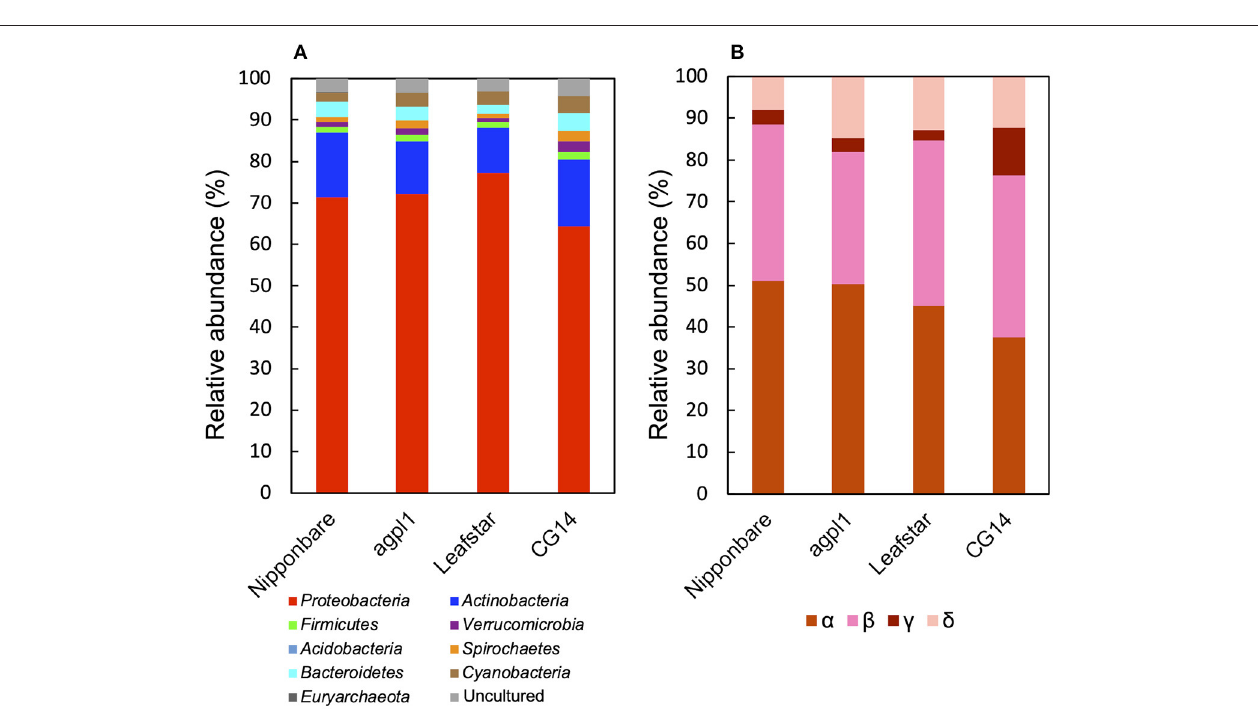
FIGURE 7 | Relative abundance of the phylum (A) , subdivision of Proteobacteria (B) based on NifH sequences obtained from the stems of four rice genotypes at the heading stage during the field experiment in 2018. Mean relative abundance of the NifH-OTUs in each rice genotype were used for calculations ( n = 2 for Nipponbare; n = 3 for agpl1, Leafstar, and CG14). The letters α , β , γ , and δ indicate alpha-, beta-, gamma-, and delta-proteobacteria, respectively. Varying taxonomic affiliation of NifH-OTUs, amino acid sequences were BLASTp searches against the non-redundant protein sequence (nr) database for ≥ 0.5% relative abundance OTUs and nifH_database_2012 ( Gaby and Buckley, 2014) for < 0.5% relative abundance OTUs. If the closest sequence identity was < 90%, it was assigned as an uncultured